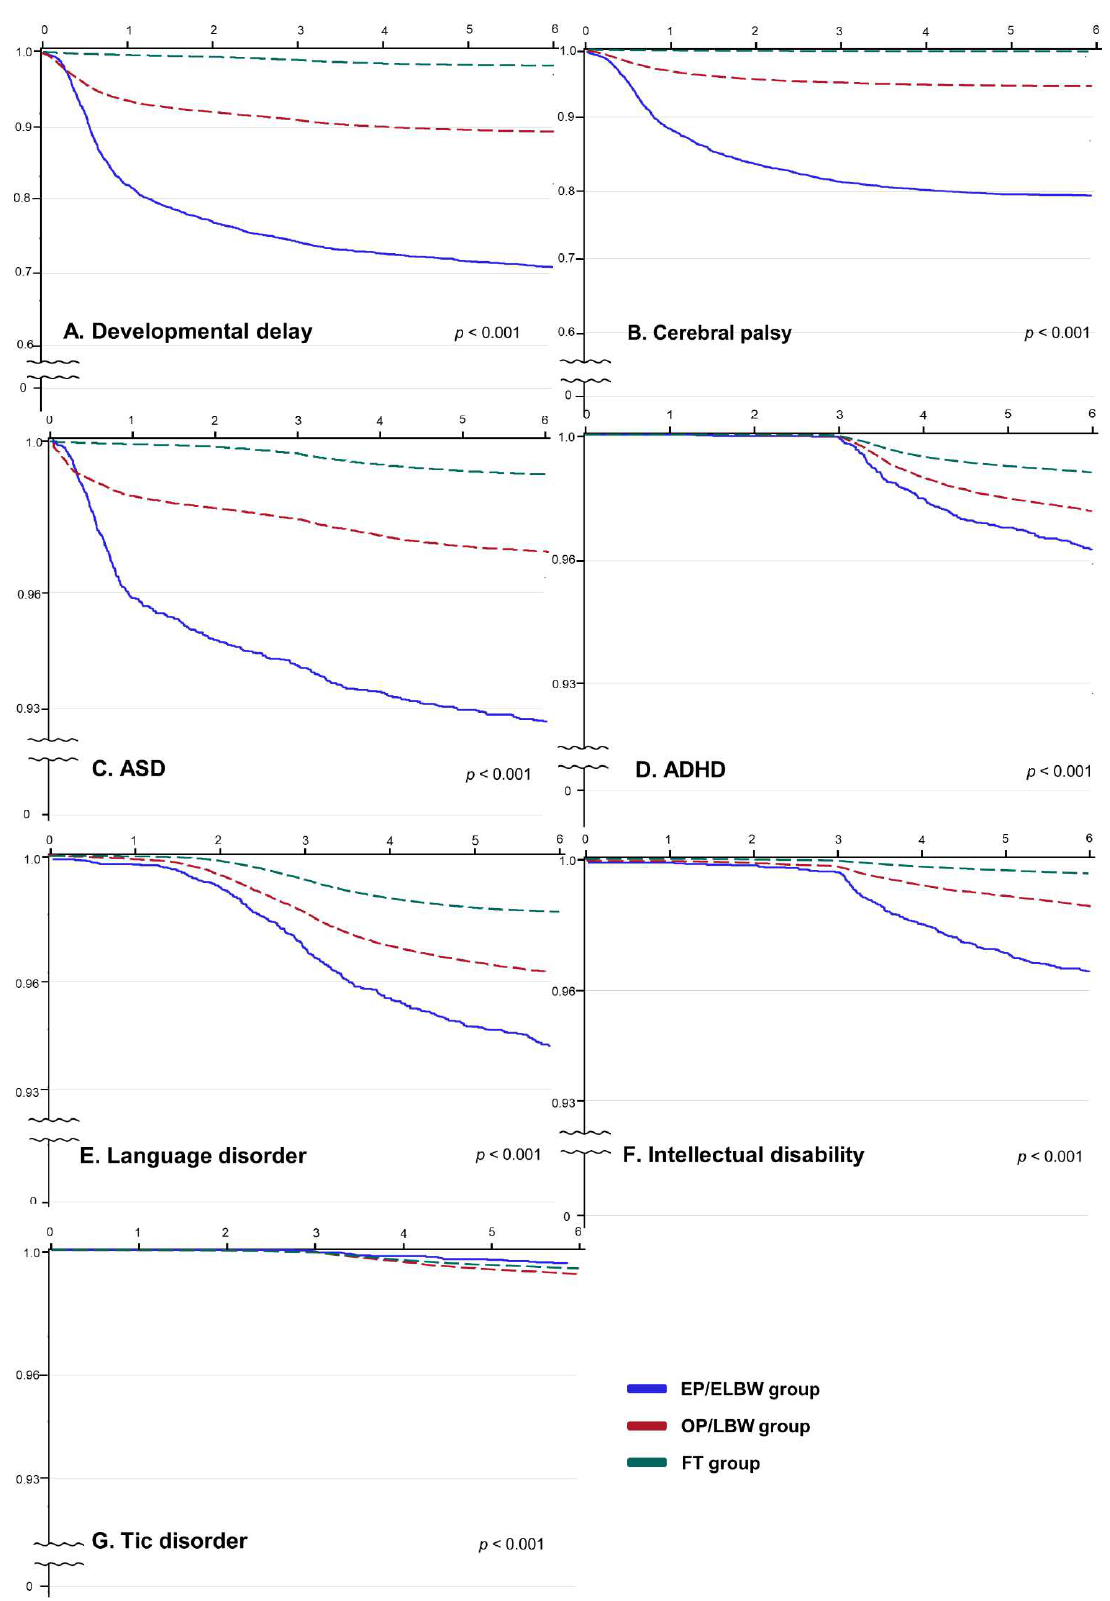
Figure 2. Comparisons of the probability of neurodevelopmental disorders in a pediatric population stratified by the degree of prematurity. All subjects are plotted against follow-up years until six years of age. The solid blue line represents the EP/ELBW group, the red dotted line represents the